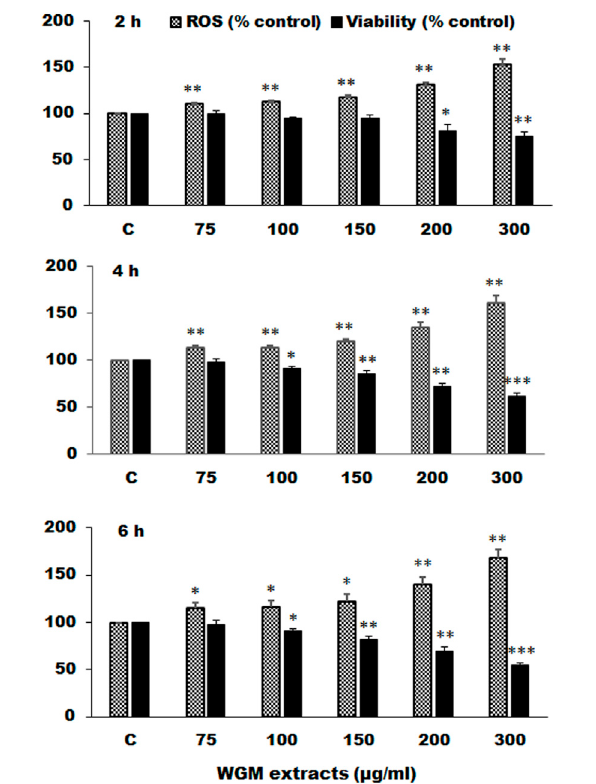
FIGURE 6 | Effects of WGM extracts on reactive oxygen species (ROS) production in Hep3B cells. Hep3B cells were incubated with vehicle alone (C) or with various indicated concentrations of WGM extracts for 2, 4, and 6 h. After treatment, cells were loaded with 5 μ M CM-H 2 DCFDA for 30 min. ROS fl uorescence was measured using a multiwell plate reader at an excitationwavelengthof485 nmandanemissionwavelengthof538 nm.MTT assay was also performed to determine the cell viability after treatment with WGM extracts for indicated times. Data represent the mean percentage of control ±S.D. ( n = 4). * p < 0.05, ** p < 0.01, *** p < 0.001 compared to the corresponding control